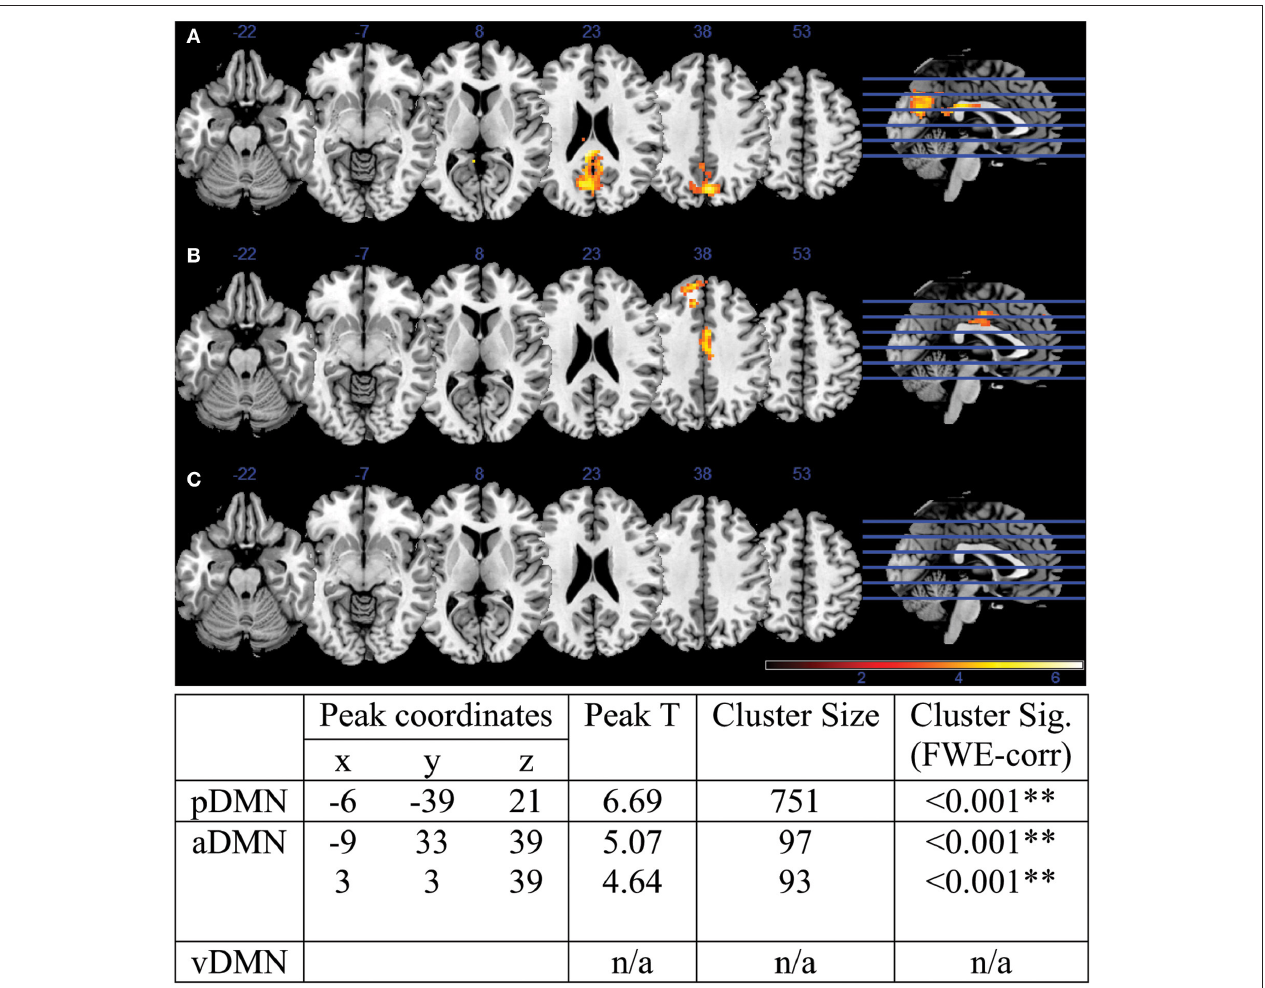
FIGURE 2 | DMN co-activation Young vs. Old contrast for (A) pDMN component, (B) aDMN component, and (C) vDMN component. Attached table illustrates peak coordinates, peak t -statistics, as well as cluster statistics and cluster significance. Two of the three identified DMN components exhibited statistically different activation maps between the young and older adults: the pDMN and aDMN, with pDMN presenting 1 cluster of difference in the pC/PCC and aDMN presenting 2 cluster in the middle cingulum and mPFC over the whole